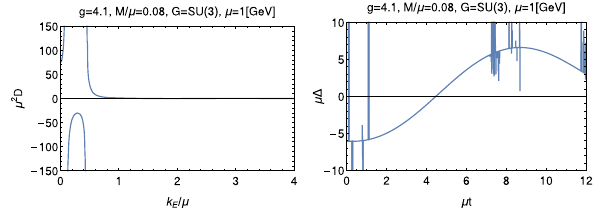
Fig. 12 The same plots as those given in Fig. 7 for a physical coupling constant g = 4 . 1andamuchsmallermass M /μ = 0 . 08.Forthischoice